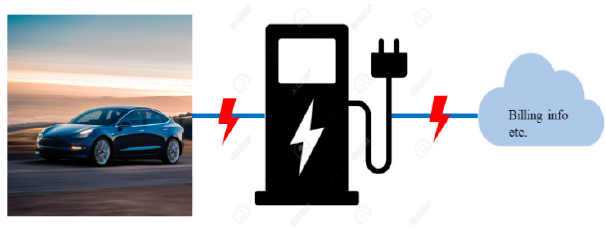
Figure 12. Interception of information via charging stations [75].